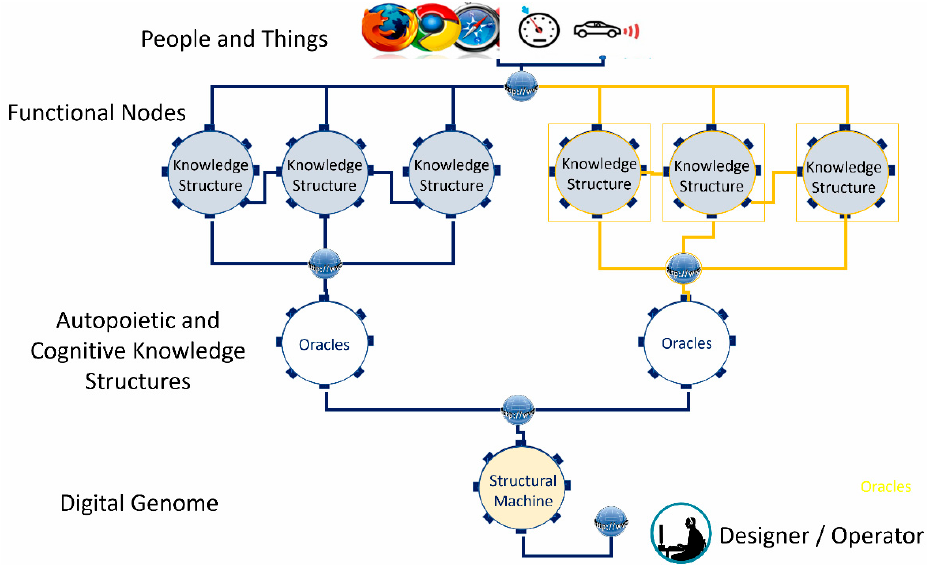
Figure 5. Knowledge network where each node performs several functions based on inputs received from various ports and communicates information to other nodes through output ports. The nodes wired together fire together to execute collective behaviors.